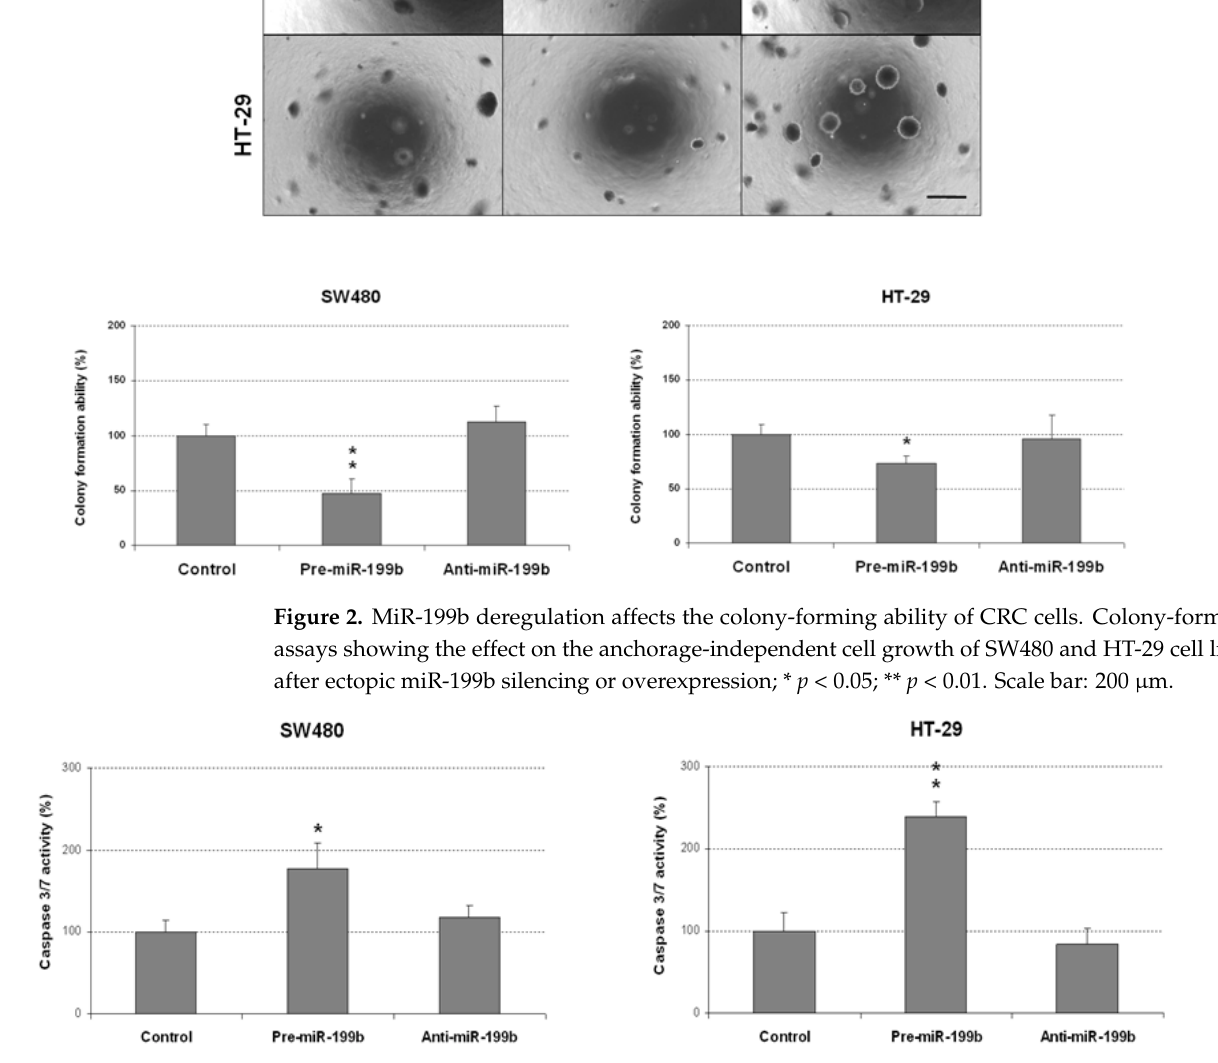
Figure 3. MiR-199b induces apoptosis in CRC cells. Caspase-3/7 activity assay showing levels